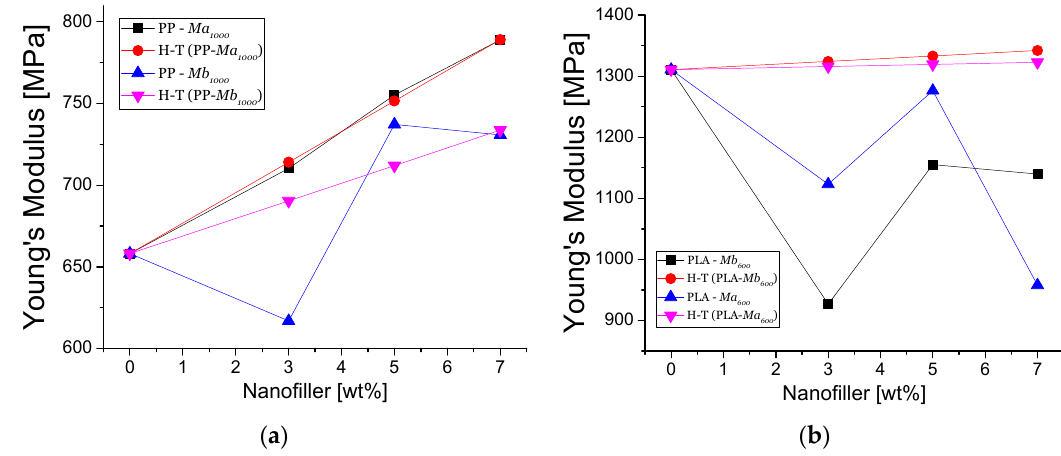
Figure 6. Halpin Tsai model for nanocomposites of PP-TrGO:Fe 3 O 4 ( a ) and PLA-TrGO:Fe 3 O 4 ( b ).